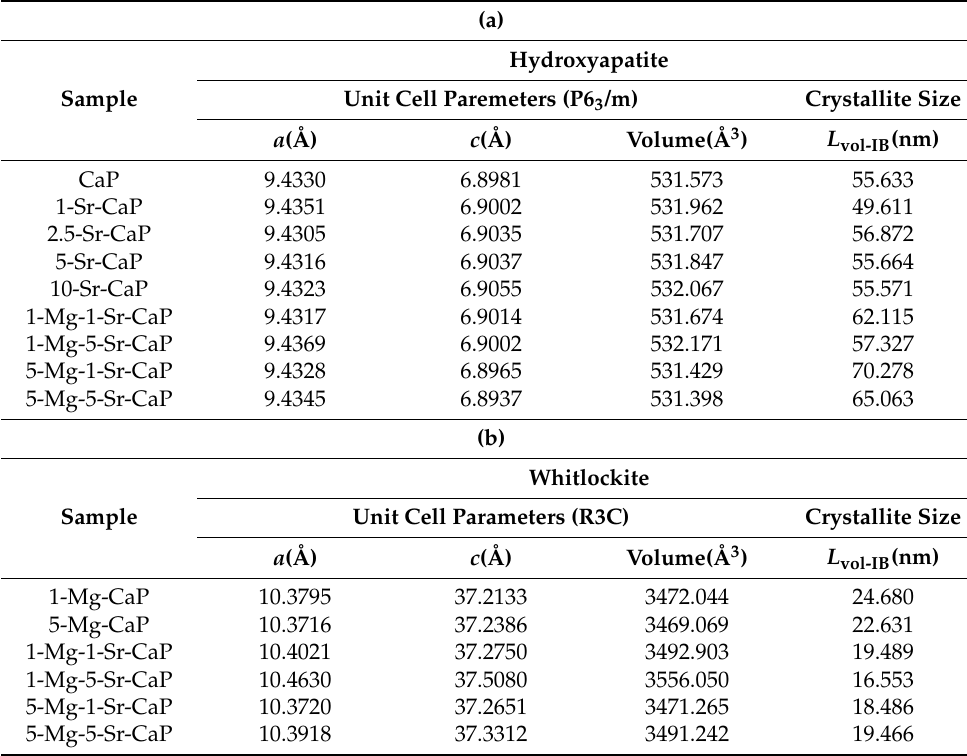
Table 3. Unit cell parameters of the HAp and WH phase in Sr-substituted and Mg- and Sr-co- substituted systems obtained by the whole powder pattern decomposition refinements of the XRD